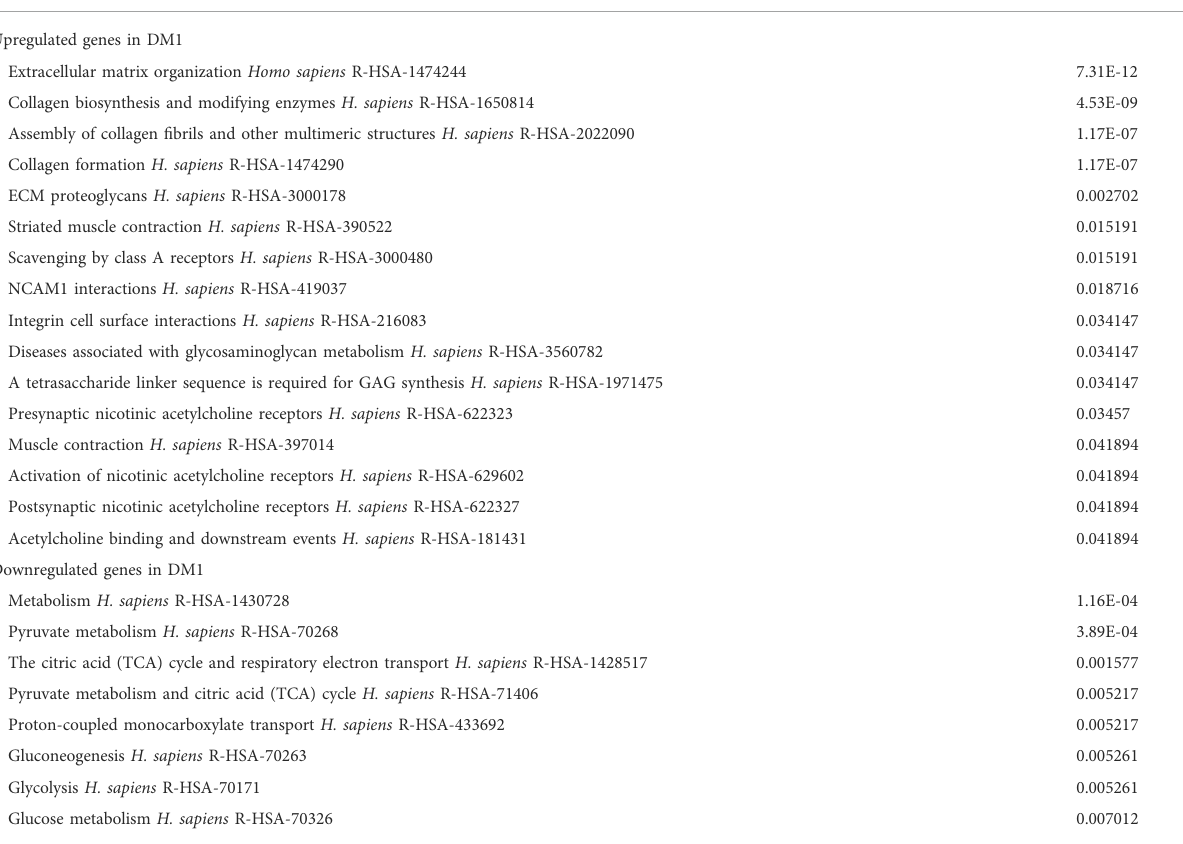
TABLE 1 Reactome pathways enriched for the differentially expressed genes in DM1. FDR-adjusted p -values are presented.